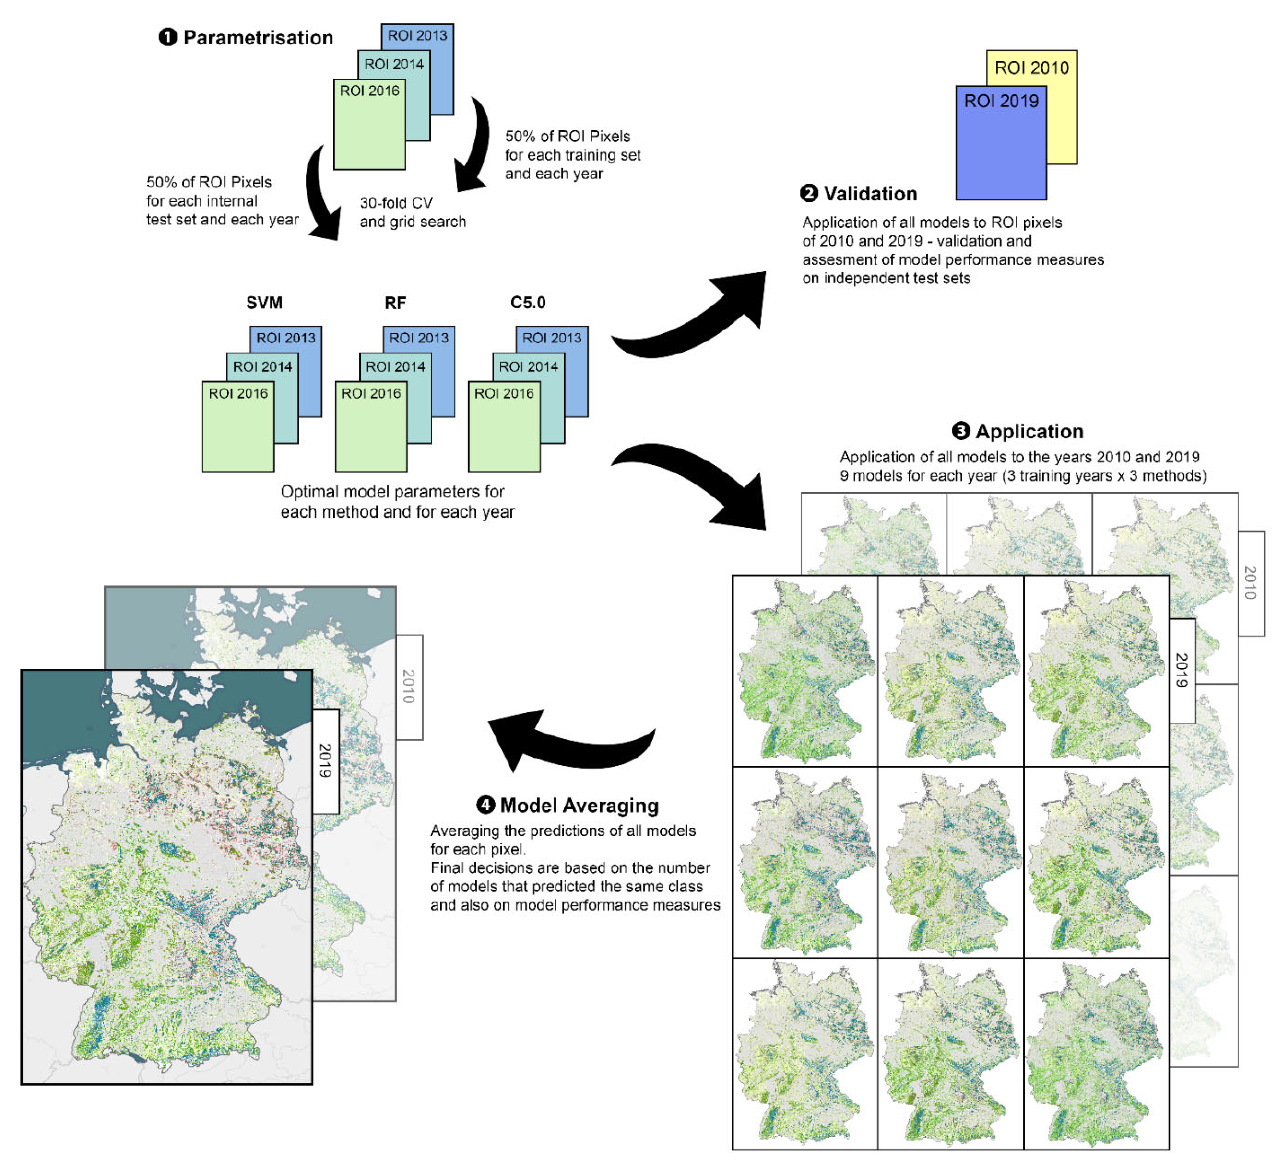
Figure 2. Methodology scheme of the classification process. Three machine learning algorithms (SVM, RF, C5.0) are trained and tested using grid search and 30-fold cross-validation on training years 2013, 2014, and 2016 individually and then validated with independent test sets consisting of ROIs from 2010 and 2019. Each model combination (training year and method) is applied to the study area of 2010 and 2019, respectively, resulting in 9 predictive models for each test year. Predictions are averaged by majority vote to generate a final ensemble class